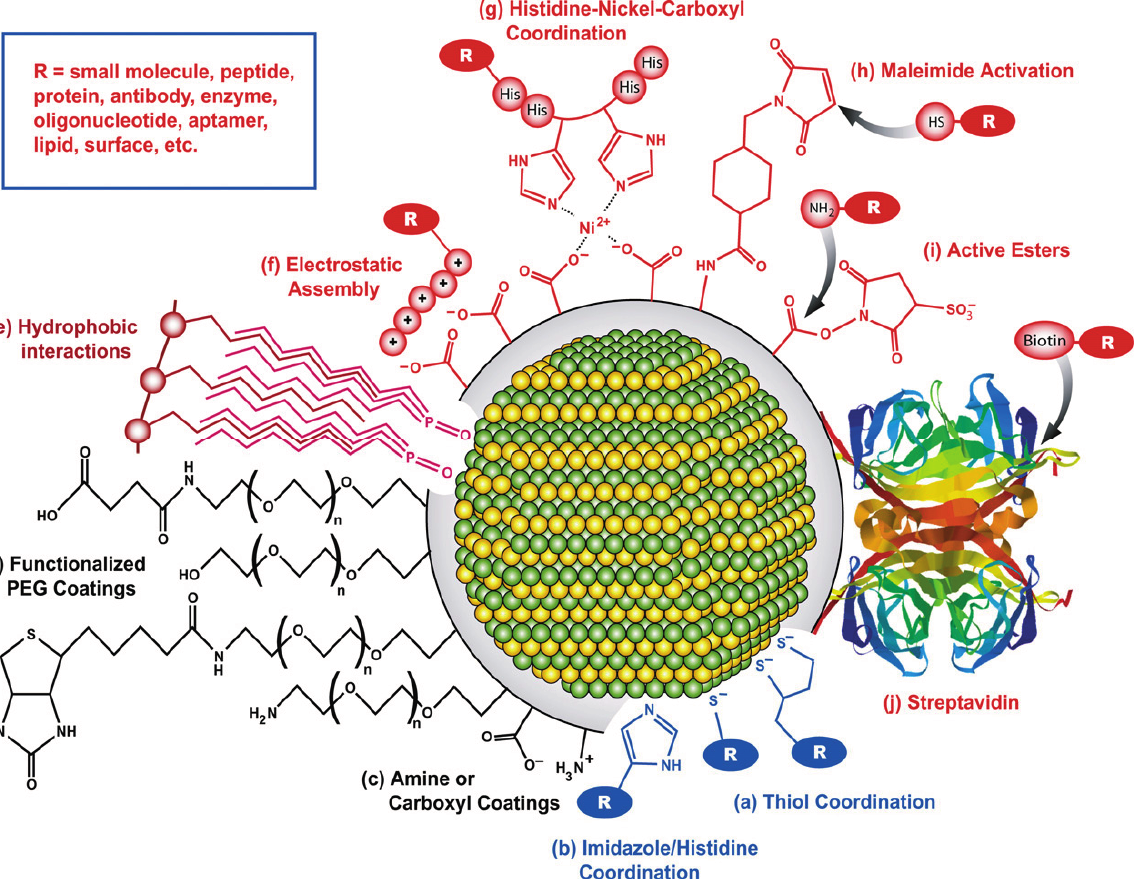
Figure 2. Bioconjugation schemes for QD functionalization including ( a ) thiol coordination; ( b ) polyhistidine groups; ( c ) amine/carboxyl moieties; ( d ) PEG; ( e ) hydrophobic interactions; ( f ) electrostatic adhesion; ( g ) nickel mediated polyhistidine; ( h ) maleimide covalent linkage; ( i ) active esters; and ( j ) biotin-streptavidin complexes. Figure used with permissions of publisher